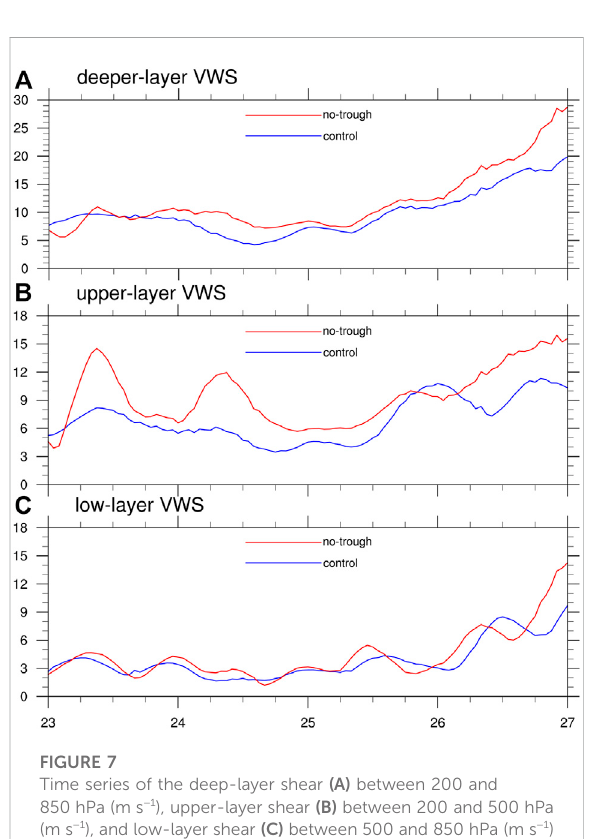
FIGURE 7 Time series of the deep-layer shear (A) between 200 and 850 hPa (m s − 1 ), upper-layer shear (B) between 200 and 500 hPa (m s − 1 ), and low-layer shear (C) between 500 and 850 hPa (m s − 1 ) in CTRL (blue) and No-trough (red), respectively.